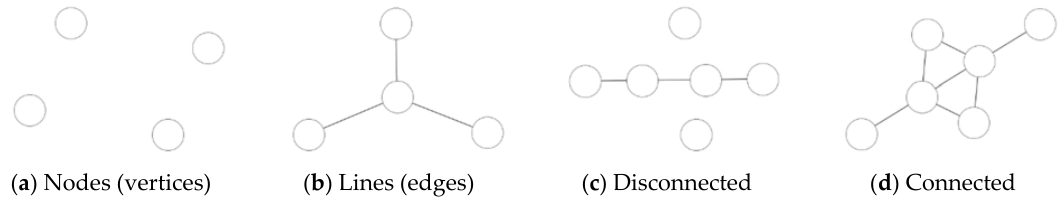
Figure 6. Schematic representations of ( a ) nodes and ( b ) lines and ( c , d ) their connectivity.